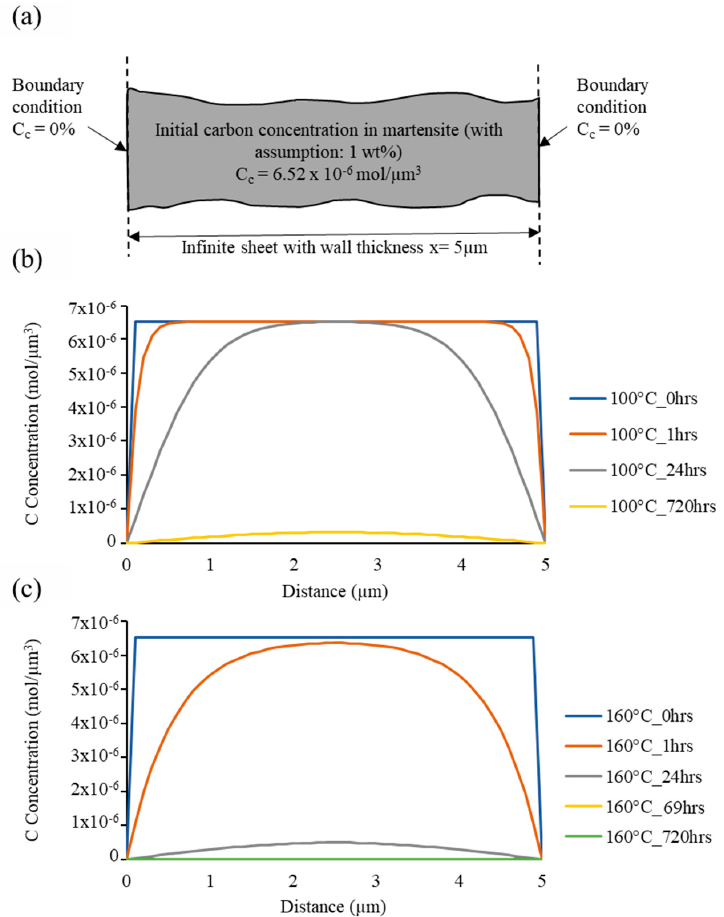
Figure 4. ( a ) Schematic for carbon diffusion in a 5 μ m thick ferrite plate. Change in carbon concentration due to diffusion at ( b ) 100 °C and ( c ) 160 °C.